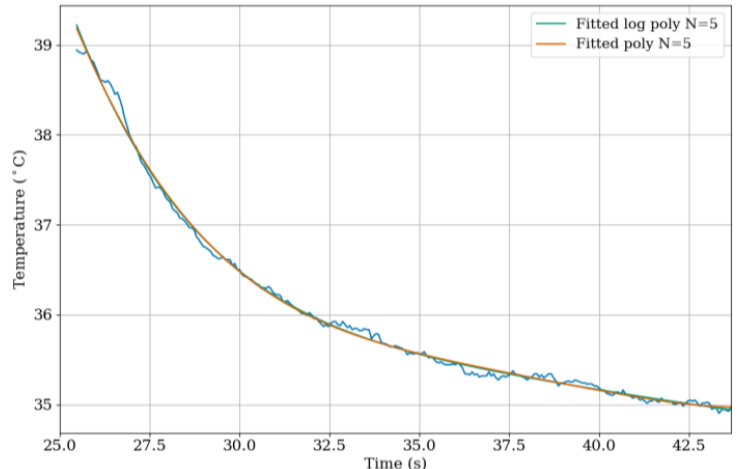
Figure 6. A plot showing TSR fitting to recorded data using 5th-order polynomial and log polynomial. The blue line denotes the raw data.